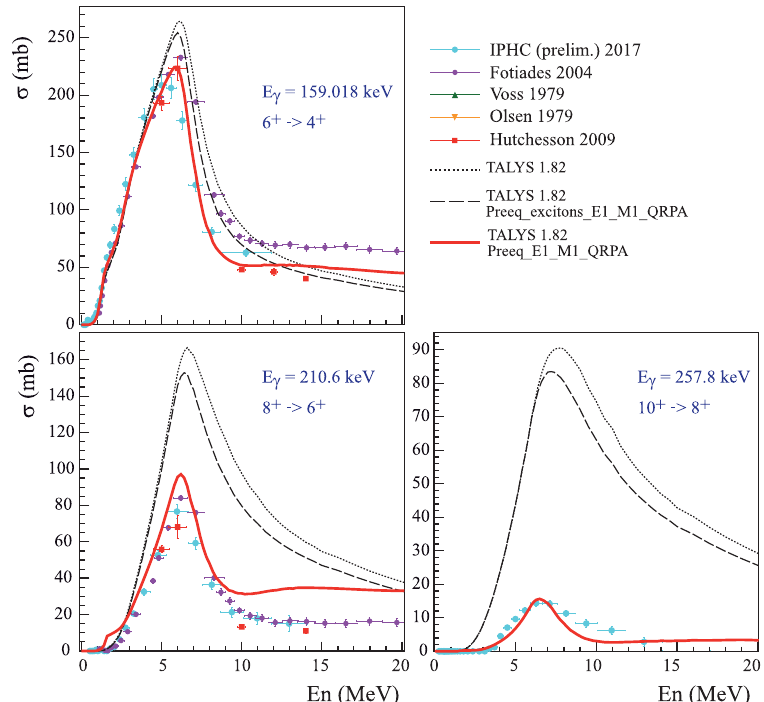
Fig. 9. Comparison between measured 238 U(n,n 0 g ) cross sections for transitions within the ground state band and TALYS calculations with different models inputs. Our experimental data are compared to those from Hutcheson et al. [15], Fotiades et al. [16], Olsen et al. [17], Voss et al. [18]. The TALYS calculations are made either with exciton model for pre-equilibrium and E1 – M1 gamma strength function from RIPL (cid:2) dashed black line, or with exciton model for pre-equilibrium and E1 – M1 gamma strength function from QRPA calculations (cid:2) long dashed black line or with pre-equilibrium and E1 – M1 gamma strength function from QRPA calculations (cid:2) red